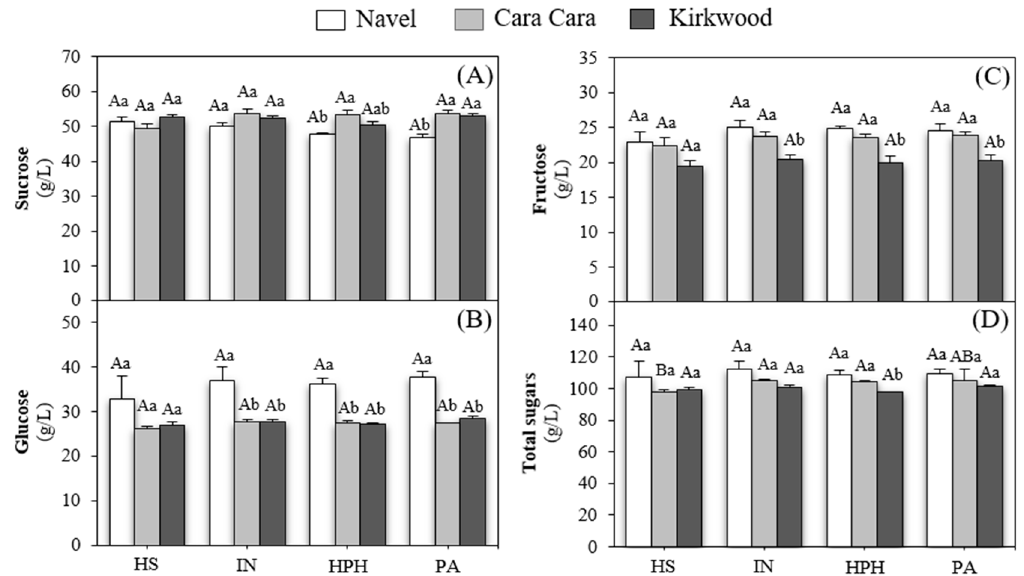
Figure 6. Content of sucrose ( A ), glucose ( B ), fructose ( C ), and total sugars ( D ) in hand-squeezed (HS), industrial (IN), HPH, and pasteurized (PA) juices of N, CC, and K orange. Uppercase letters indicate significant differences among different type of juices for the same variety, and lowercase letters indicate significant differences among varieties for the same type of juice one-way ANOVA ( p < 0.05).